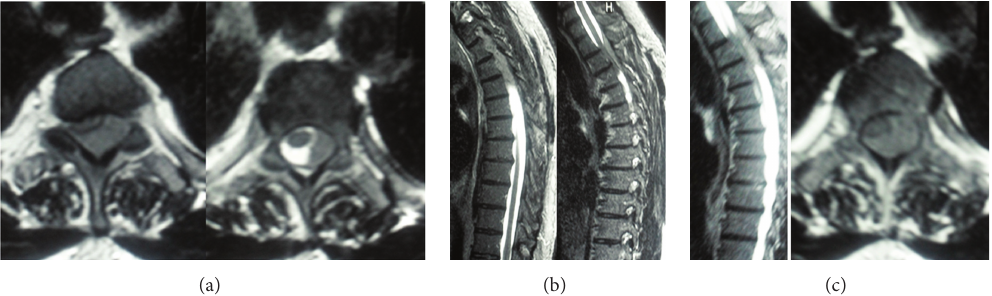
Figure 1: (a) Axial T2-weighted MRI shows thoracic epidural lesion with cord compression at the T2–T4 levels, extending to the paraspinal muscles. (b) Sagittal T2-weighted MRI shows dural mass. (c) Images showing T2-weighted sagittal and axial MR scans.